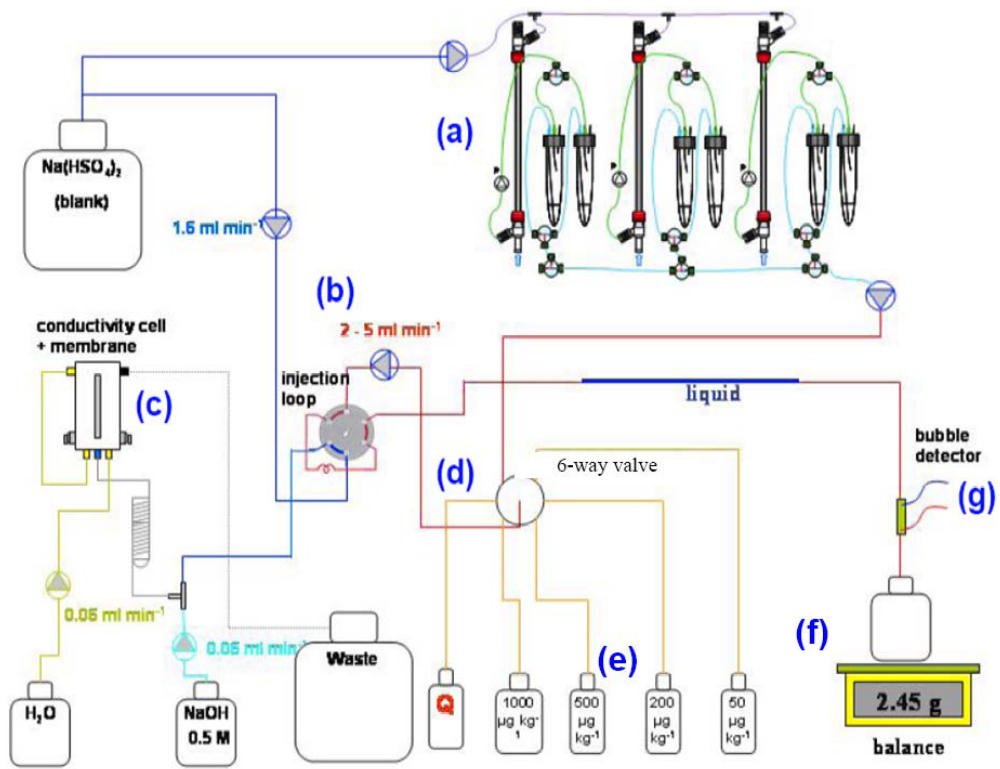
Fig. 2. Scheme of the ROSAA analyser. (a) The three denuders to sample the air and two reservoirs per denuder to store the liquid while analysing. (b) The injection valve to analyse successively the reservoirs and the standards. (c) The ammonium analyser by conductivity and membrane separation. (d) Electro-valves to sample either from the denuder or the standards. (e) The four standards which are sampled every 2h. (f) the balance to measure the mass of liquid in each reservoir. (g) The bubble detector to control the injection of liquid.